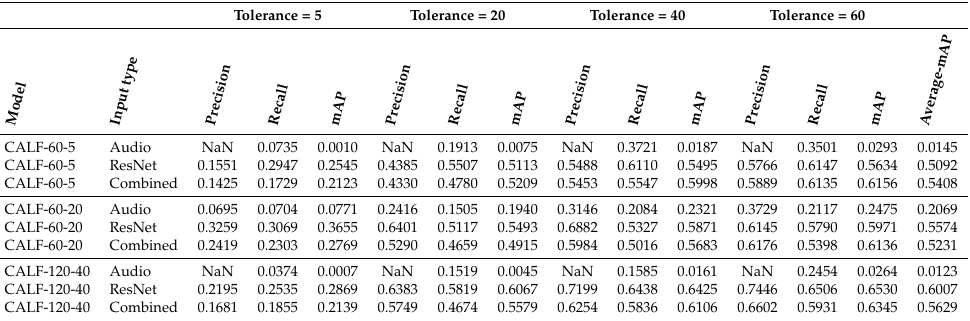
Table 8. Performance of the CALF [4] model with different configurations, tested on the test set. The mAP values indicate the Average Precision values averaged over all event types. The Combined input type is the integration of the ResNet and the audio